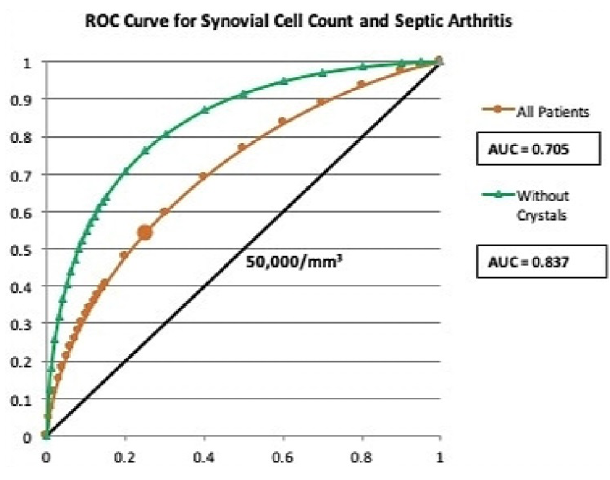
Figure 1. Receiver operating characteristics curve for synovial WBC cut-off of 50,000/mm 3 in diagnosis of septic arthritis.